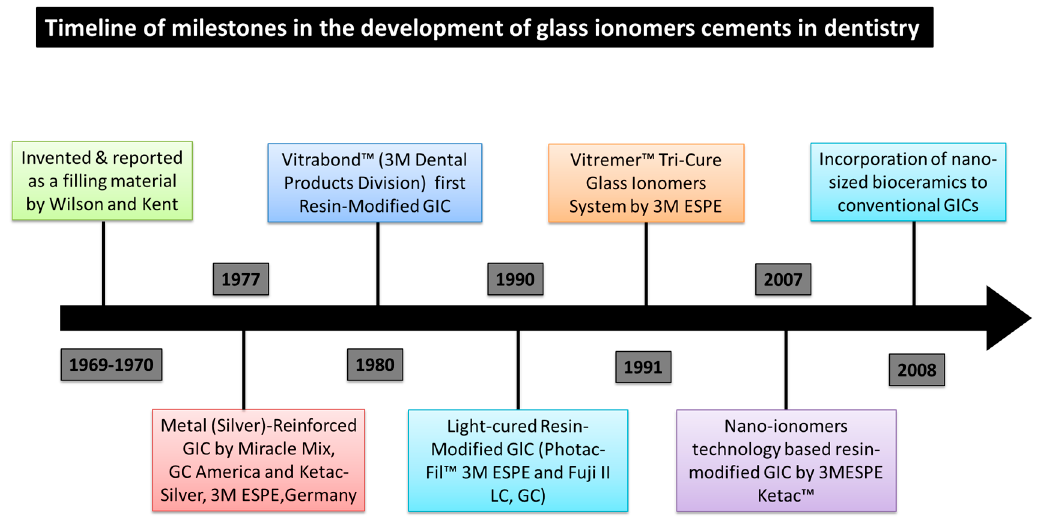
Figure 1. A timeline of the development and advances in glass ionomer cements (GICs). Originally invented as powder and liquid formulation by Wilson and Kent, GICs have undergone a number of modifications to improve their mechanical properties. More recently, nano-filled resin modified and conventional glass ionomers have been developed.